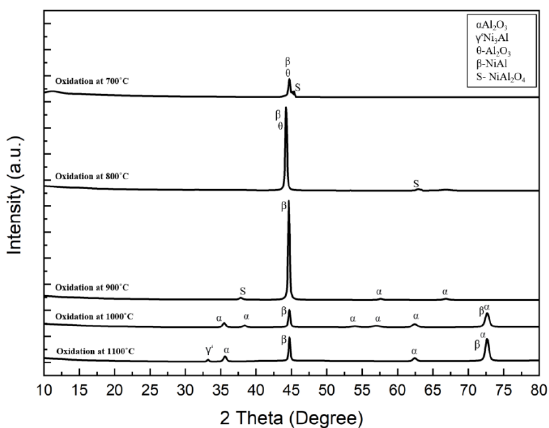
Figure 9. The XRD spectrum of aluminized samples after oxidation treatment at 700 °C–1100 °C for 8 h. The peaks confirm the presence of various oxide morphologies for each oxidizing temperature. Figure 9 represent the X-ray diffraction pattern of the oxidized samples. The XRD was operated at 30 mA, 40 kV using CuKα radiations. At low temperatures , 700 °C–800 °C, transient oxides, i.e., θ -Al 2 O 3 , along with the spinel phase of NiAl 2 O 4 [35], were formed, thereby triggering weight gains, as indicated earlier.